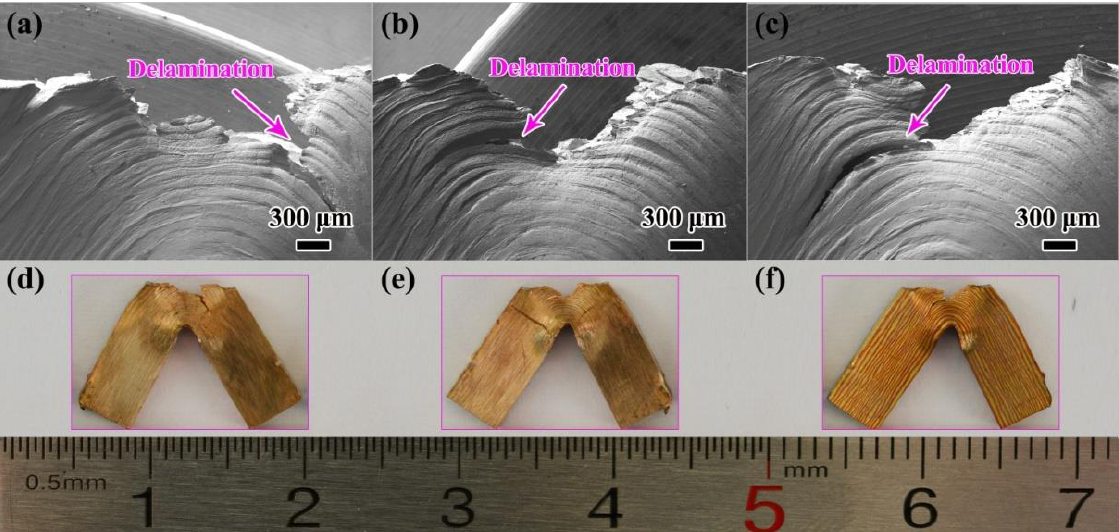
Figure 6. The images of the impacted copper – brass blocks at different temperatures: ( a – c ) the SEM images around the V-notch for fractured copper – brass blocks at LNT, RT, and 200 °C, respectively; ( d – f ) the optical images for fractured copper – brass blocks at LNT, RT, and 200 °C, respectively.